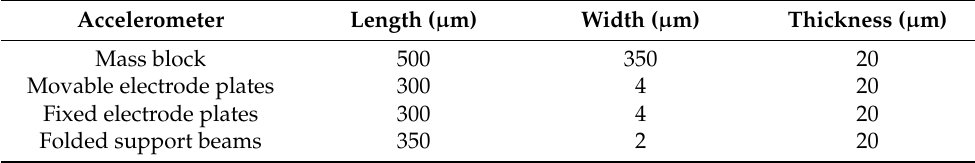
Table 1. The initial values of the structural parameters for the capacitive accelerometer. Accelerometer Length ( µ m) Width ( µ